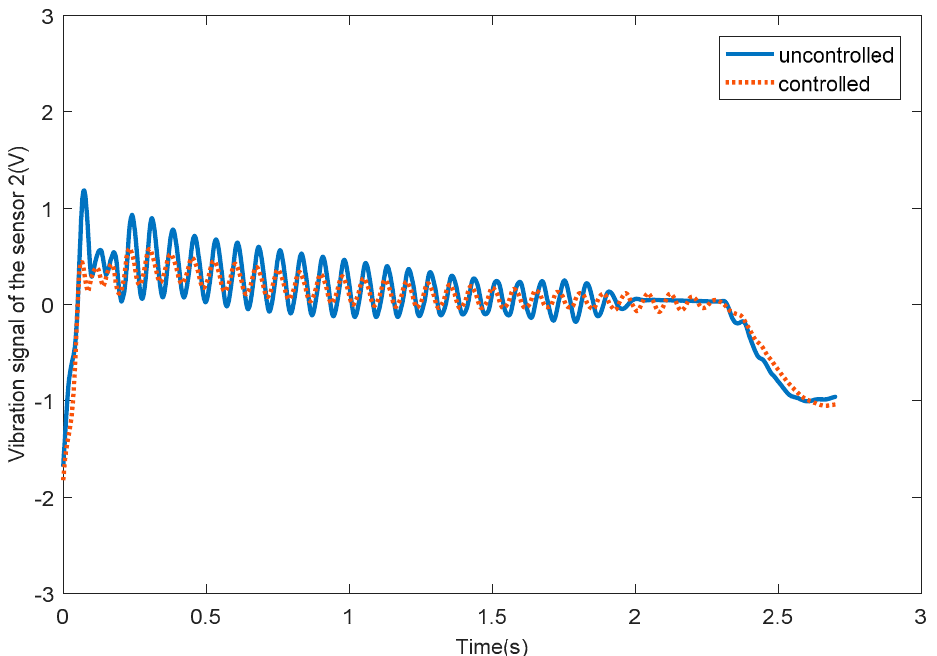
Figure 17. The vibration signals of passive flexible link 2 for the uncontrolled and controlled systems.